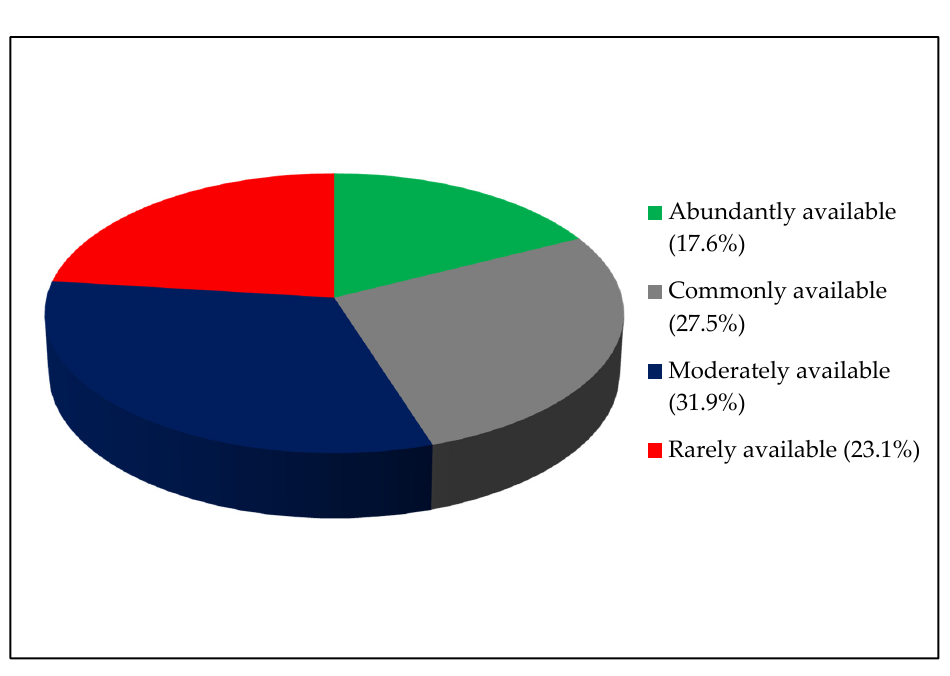
Figure 5. Habitat preference of the freshwater fishes in the study area.